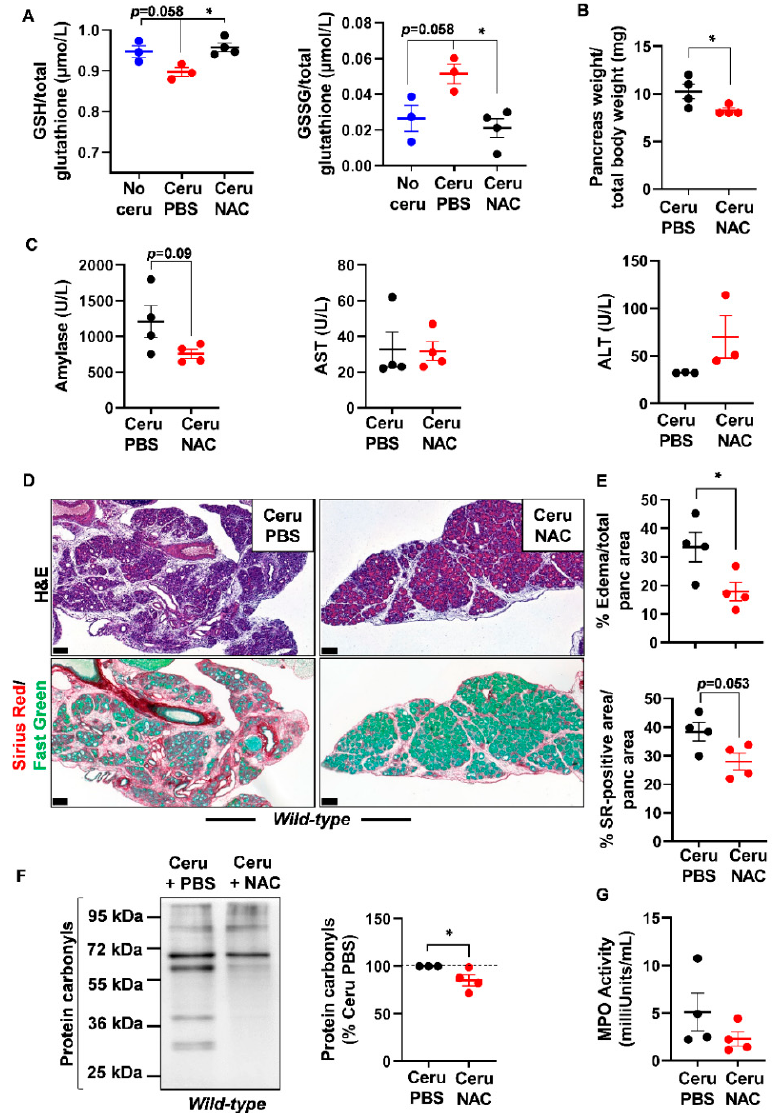
Figure 4. N-acetylcysteine treatment improves acute pancreatitis hallmarks in wild-type mice. ( A ) Reduced glutathione (GSH) and glutathione disulfide (GSSG) measurements in pancreas lysates of wild-type ( WT ) mice treated with cerulein and PBS for 5 days (Ceru PBS; n = 3), cerulein and NAC for 5 days (Ceru NAC; n = 4) or untreated (No ceru; n = 3). ( B ) Pancreas weight normalized to total body weight in wild-type ( WT ) mice treated with cerulein and PBS for 5 days (Ceru PBS; n = 4) or cerulein and NAC for 5 days (Ceru NAC; n = 4). ( C ) Measurement of plasma amylase , aspartate transaminase (AST) and alanine transaminase (ALT) levels in wild-type ( WT ) mice treated with cerulein and PBS for 5 days (Ceru PBS; n = 3–4) or cerulein and NAC for 5 days (Ceru NAC; n = 3–4). ( D ) Hematoxylin and eosin (H&E) staining and Sirius Red (SR) staining on the pancreata of wild-type ( WT ) mice treated with cerulein and PBS for 5 days (Ceru PBS; n = 4), or cerulein and NAC for 5 days (Ceru NAC; n = 4). Bars: 100 µ m. ( E ) Whole-tissue quantifications for edema and SR-positive areas from panel D . ( F ) Western blot for the oxidative damage marker, protein carbonyls, on pancreas lysates of wild-type ( WT ) mice treated with cerulein and PBS for 5 days (Ceru PBS; n = 3) or cerulein and NAC for 5 days (Ceru NAC; n = 4). ( G ) Myeloperoxidase (MPO) activity on pancreas lysates of wild-type ( WT ) mice treated with cerulein and PBS for 5 days (Ceru PBS; n = 4) or cerulein and NAC for 5 days (Ceru NAC; n = 4). Data are mean ± SEM. Statistical significance for Panel A was tested by one-way ANOVA test and further interactions were analyzed by post hoc test (* p < 0.05). Statistical significance for panels B – G was tested by Student’s t -test (* P <0.05). Dixon’s Q test was applied to remove outlier samples,